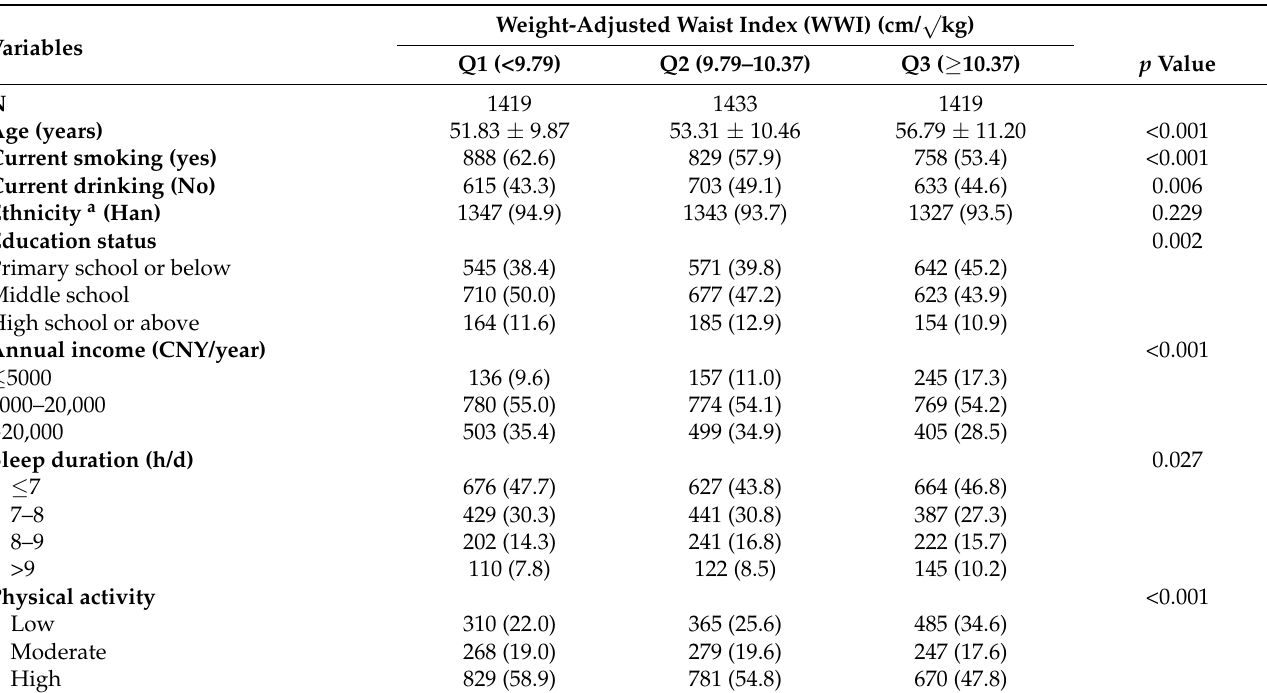
Table 1. Baseline characteristics of study participants by weight-adjusted waist index in